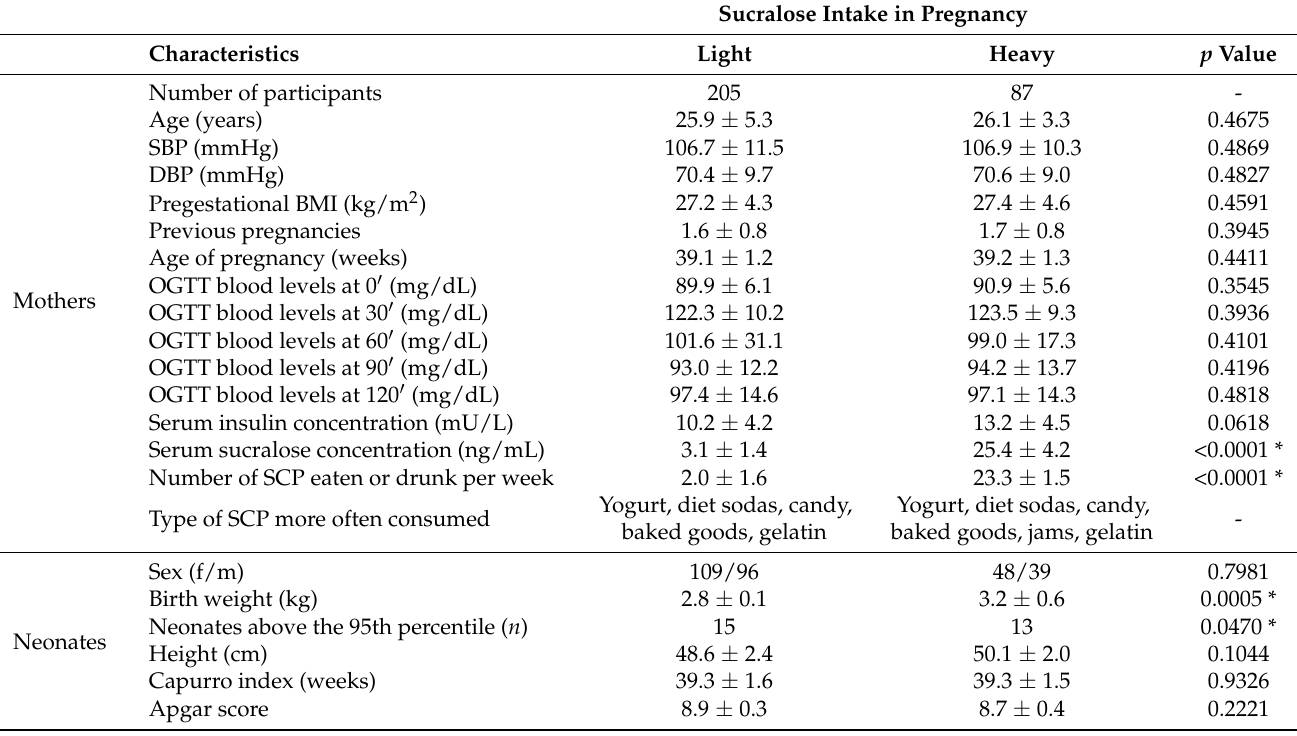
Table 1. Demographic and metabolic characteristics of the study